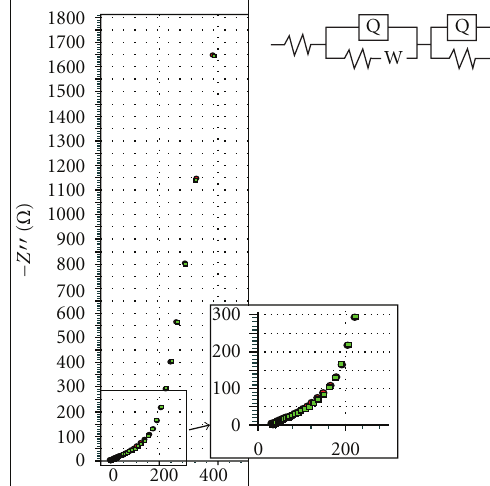
Figure 5: Comparison of experimental impedance data (o) with fitted impedance data ( (cid:2) ) based on the equivalent circuit model Q ( R R Q R R Ω ( w ))( l l ); chi-square value = 3.61 × 10 − 4 . Insets show ct the equivalent circuit model and the high-frequency region of the Nyquist